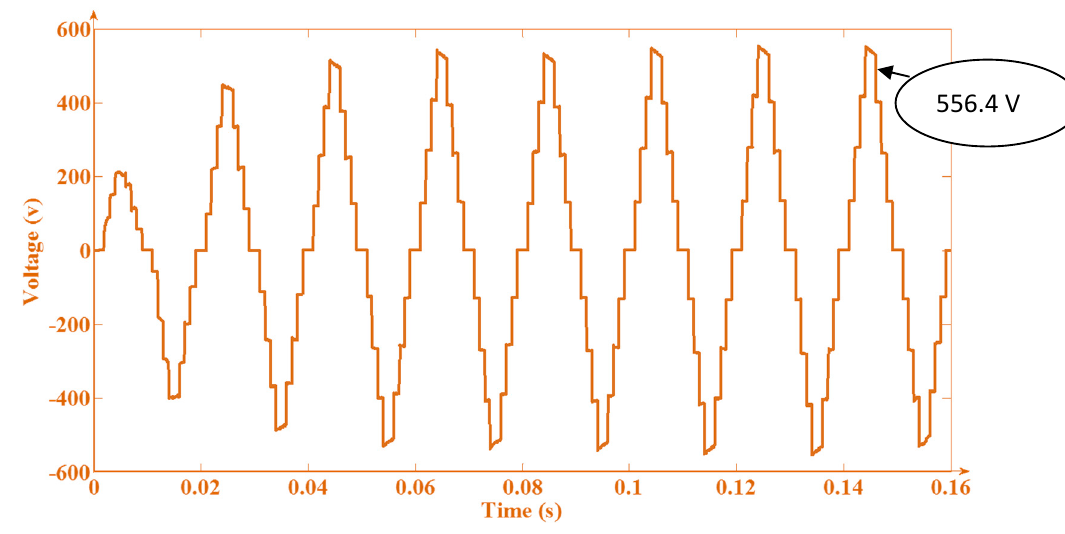
Figure 42. Stepped voltage waveform for fuzzy-based BDC.